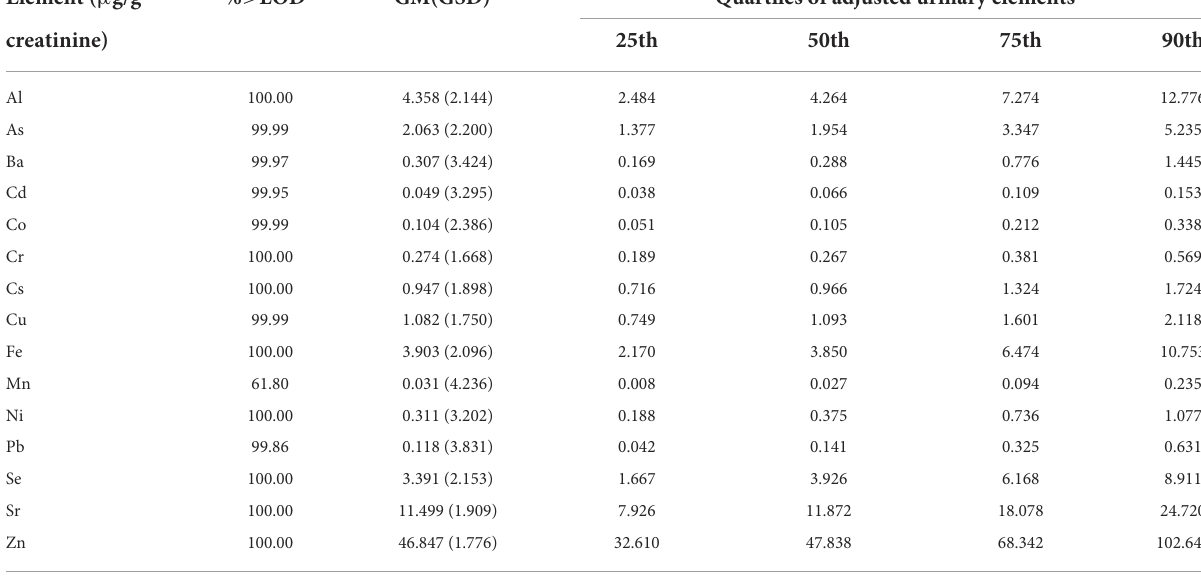
TABLE 2 Detection rates and distribution for 15 adjusted urinary elements. Element ( µ